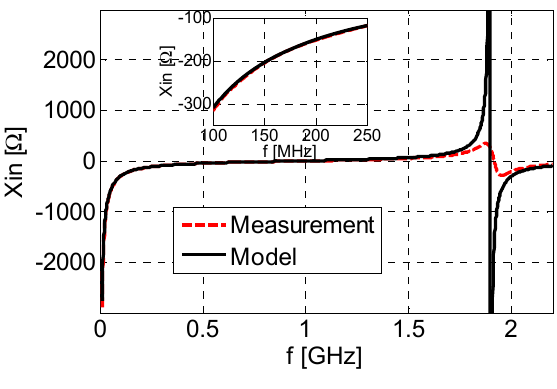
Figure 7. Comparison between the measured input reactance of the sensor, and the input reactance of the lumped-element model, in the case of the air-filled device.